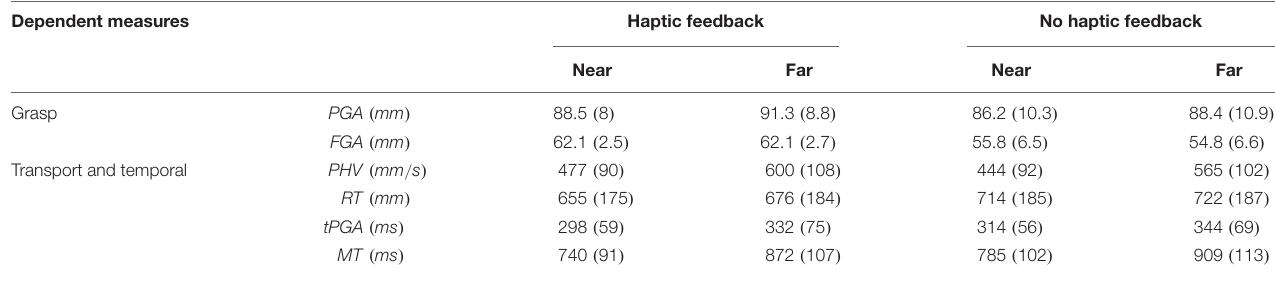
TABLE 2 | Dependent measures as a function of target distance (‘near’ and ‘far’) and haptic condition. Dependent